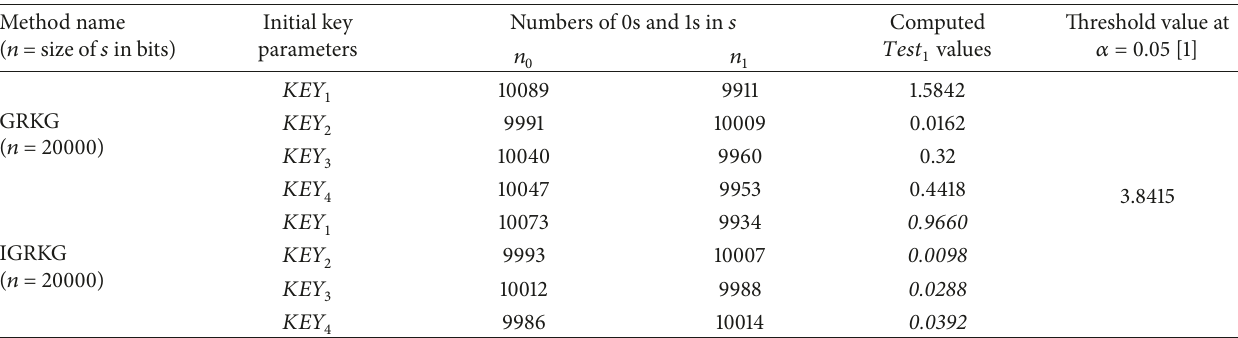
Table 7: 𝑇𝑒𝑠𝑡 1 values for a binary sequence 𝑠 of size 𝑛 = 20000 , where 𝑠 is generated individually from both the GRKG and the IGRKG generators corresponding to four different input 𝐾𝐸𝑌 parameters that have been mentioned in Table 6.